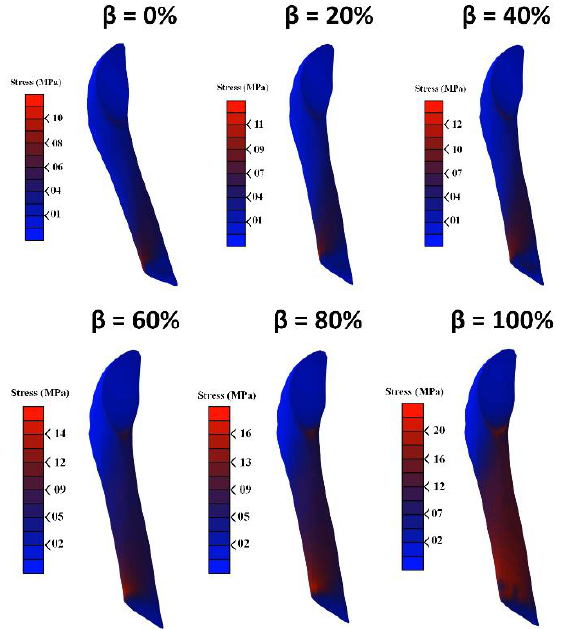
Appl. Sci. 2021 , 11 , x FOR PEER REVIEW Figure 7. Stress distribution in the ACL at 7.5% axial strain (elastic zone). Figure 7. Stress distribution in the ACL at 7.5% axial strain (elastic zone).